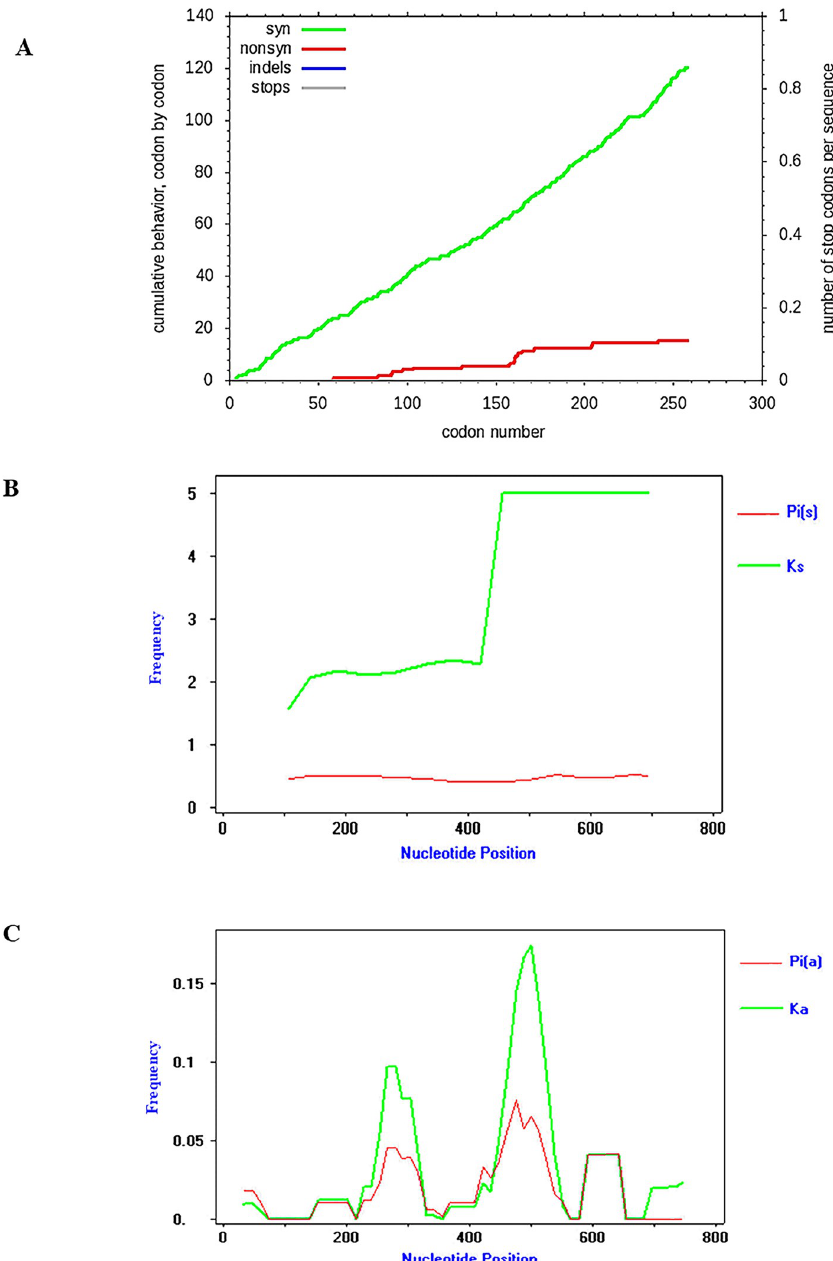
Fig 3. Synonymous and non-synonymous substitutions of partial dnaK nucleotide sequences of Coxiella sp. (A) Graph showing cumulative numbers of synonymous and nonsynonymous substitutions from all base comparisons of partial dnaK -encoding sequences. A green line indicates synonymous, and a red line indicates nonsynonymous substitutions. (B) Graph showing nucleotide diversity [Pi(s)] is still stable even when the amount of synonymous substitutions [Ks] increased. (C) Graph showing nucleotide diversity [Pi(a)] increasing at positions where non- synonymous substitution [Ka] occurs.